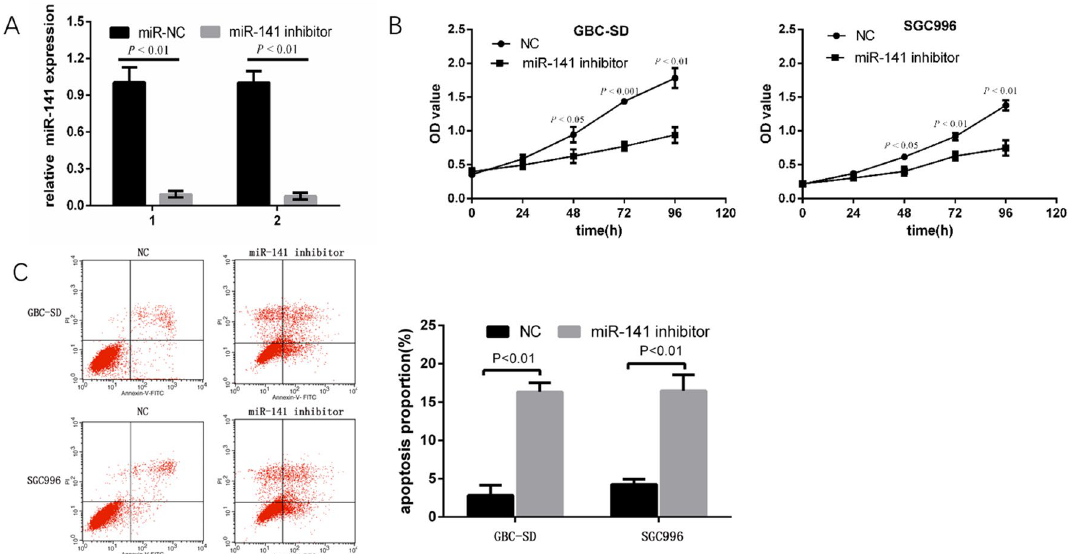
Figure 5. MiR-141 downregulated inhibited cell proliferation of GBC, but promoted cell apoptosis. ( A ) miR- 141 was significantly decreased by using miR-141 inhibitor in GBC-SD cells and SGC996 cells. ( B ) The cell proliferation of these two cell lines was determined by MTT assays. ( C ) The apoptotic rates of GBC were